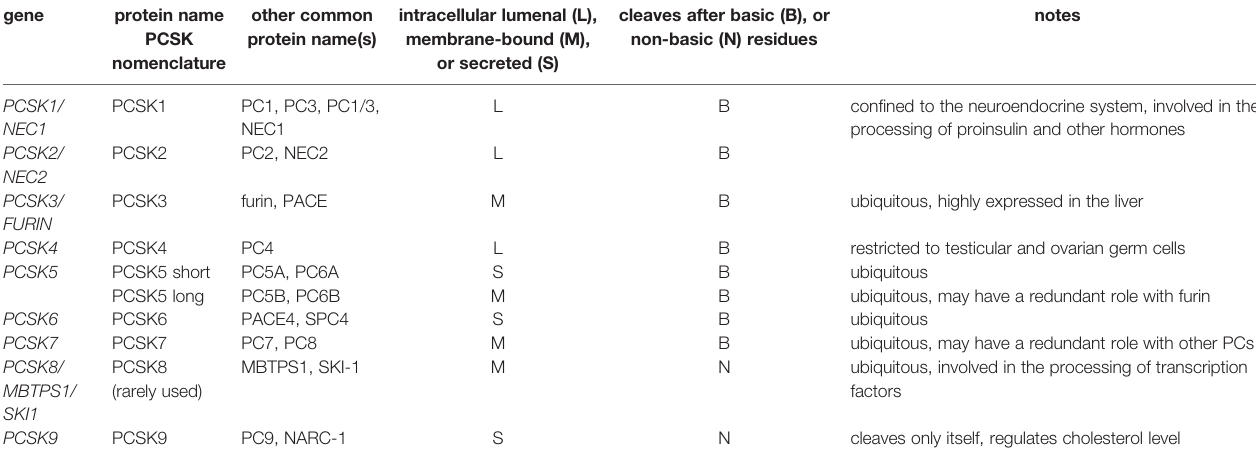
TABLE 1 | Human (mammalian) proprotein convertase genes and major protein